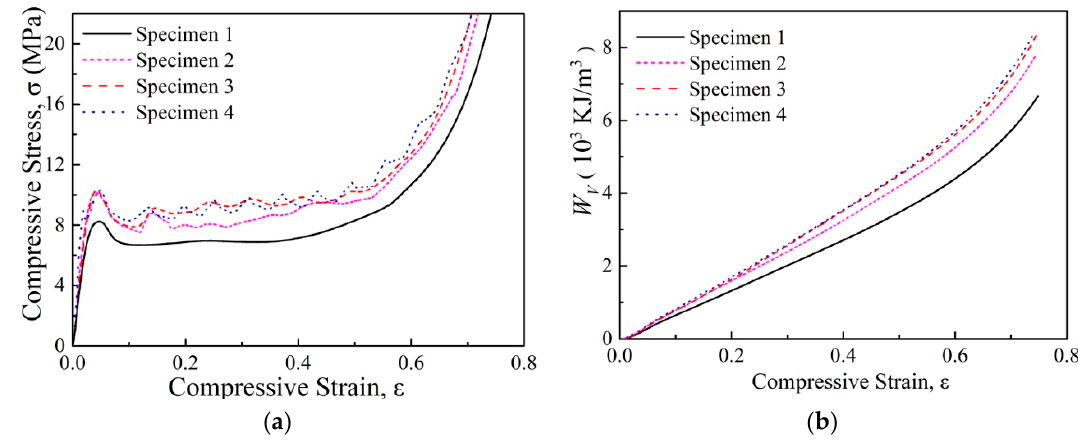
Figure 5. Compressive behaviors of tube-enhanced PMI foams. ( a ) Typical stress strain curves; ( b ) Energy absorption per volume.